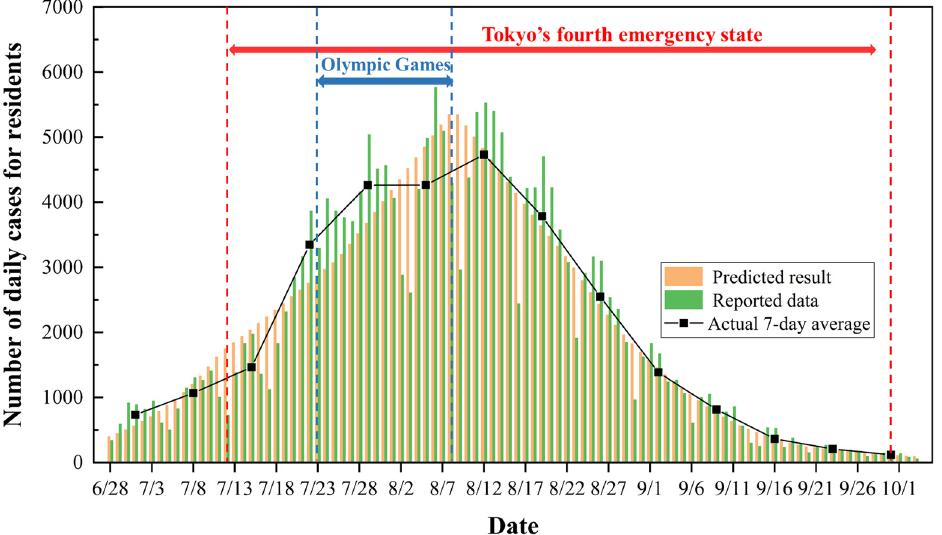
Figure 7. Comparison between predicted results and actual data for daily new cases among Japanese residents in the citywide region of Tokyo.